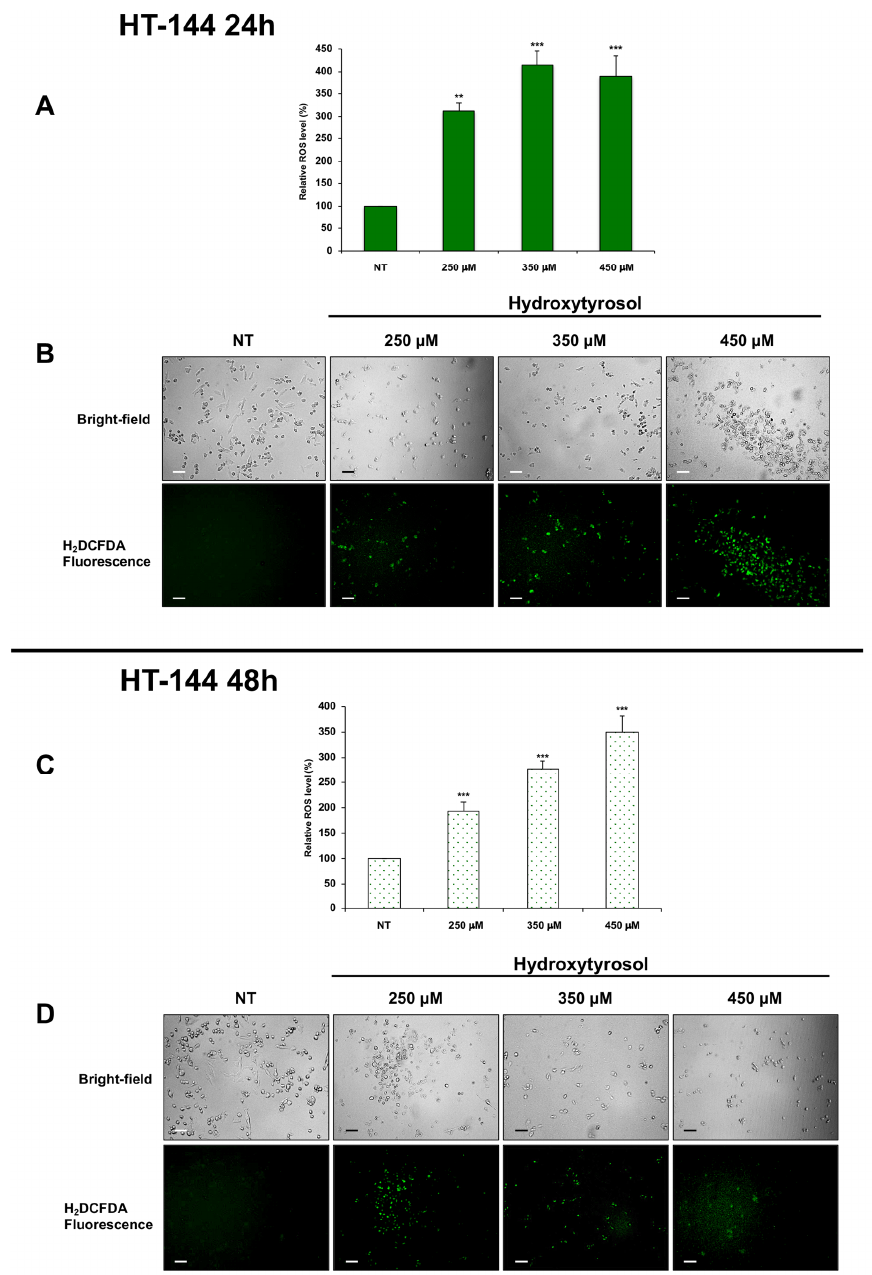
Figure 9. Amount of ROS in HT-144 cells treated with hydroxytyrosol. HT-144 melanoma cells were treated with 250 µ M, 350 µ M, and 450 µ M of hydroxytyrosol for 24 h ( A , B ), and 48 h ( C , D ). The green-fluorescent emission of DCF was quantified ( A , C ) and was analysed ( B , D ) through an inverted fluorescence microscope. The intensity of fluorescence that is directly proportional to hydrogen peroxide concentration was reported in the histograms ( A , C ) as the mean values of ROS acquired from almost three di ff erent experiments performed in triplicate and is expressed as a percent of ROS produced in unstimulated cells. The error bars indicate the standard deviation, statistical significance was analysed by Student’s t -test: ** p < 0.01 highly significant; *** p < 0.001 very highly significant. The bright-field and fluorescence photomicrography of treated and untreated HT-144 cells stained with H 2 DCFDA probe are reported in ( B , D ). Images were acquired with an inverted Leica fluorescence microscope using a × 10 objective. Scale bar: 100 µ m. The images are representative of almost three di ff erent